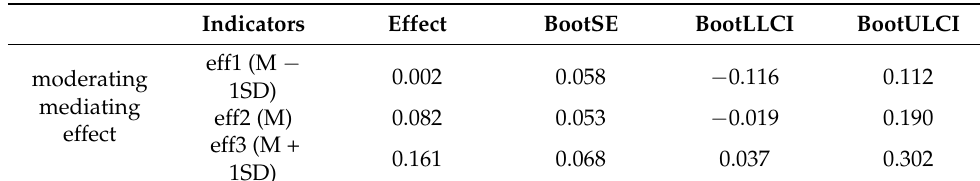
Table 7. Direct and mediated effects at different levels of self-management.